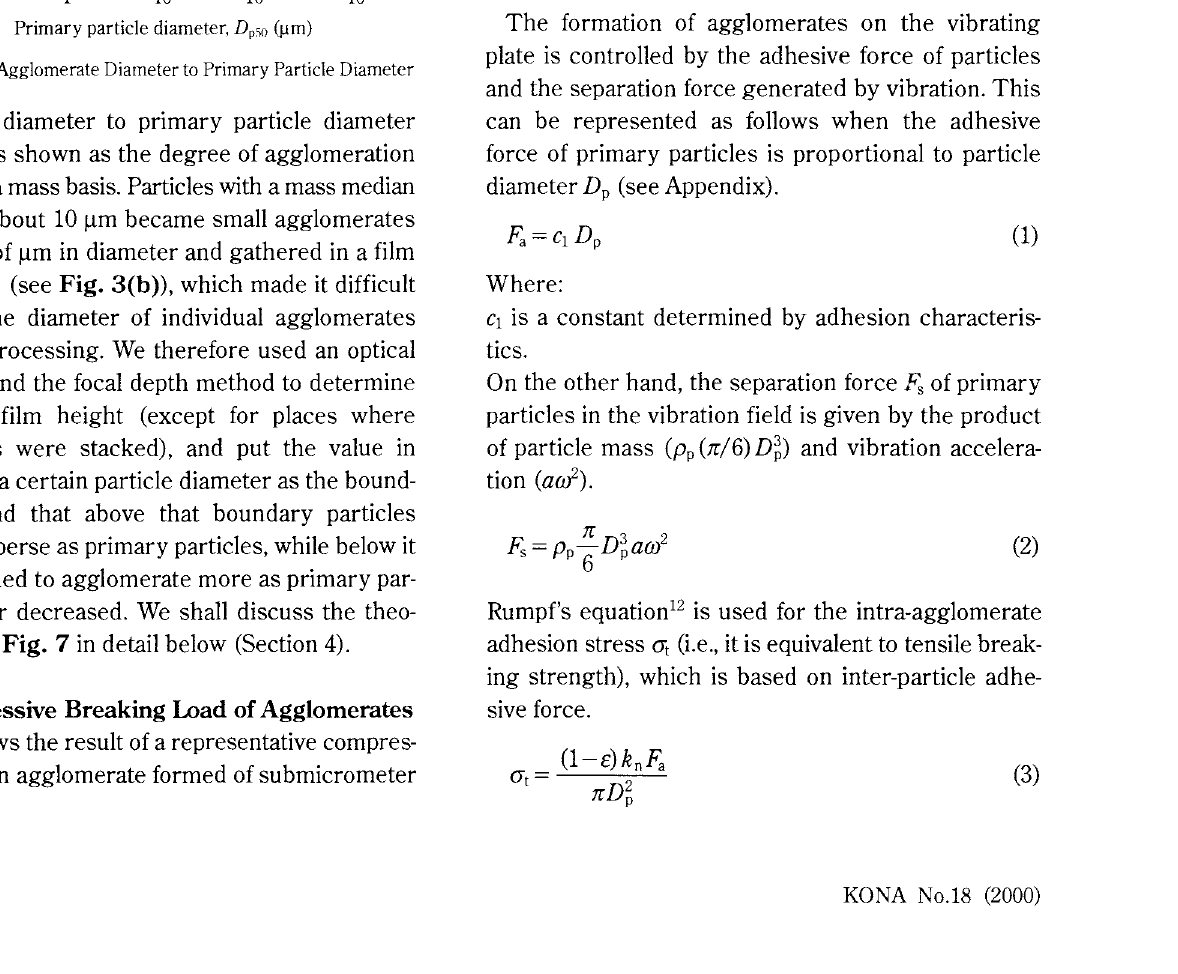
Fig. 8 Compression Test on an Agglomerate particles (Dpso=0.7 J..lm). Since the agglomerate was rather soft, displacement increased in tandem with load, and we found no distinct breaking point, but the graph shows a large change in load where relative displacement in relation to agglomerate